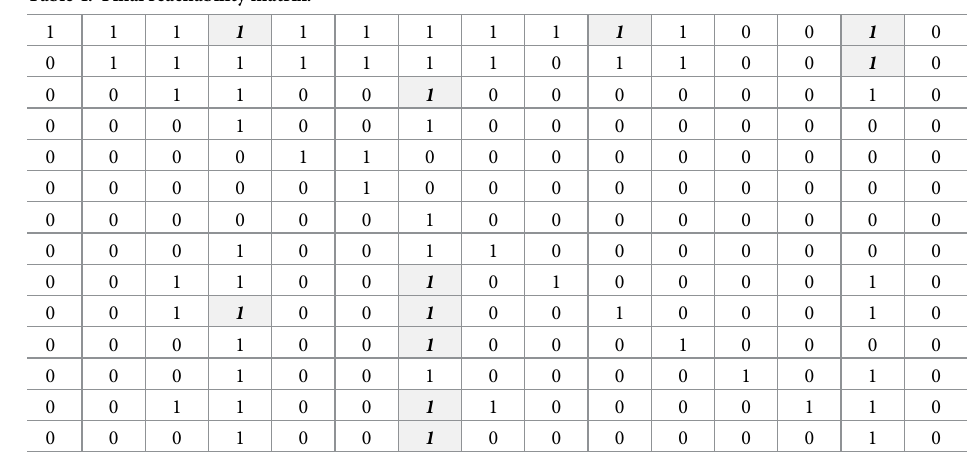
Table 4. Final reachability